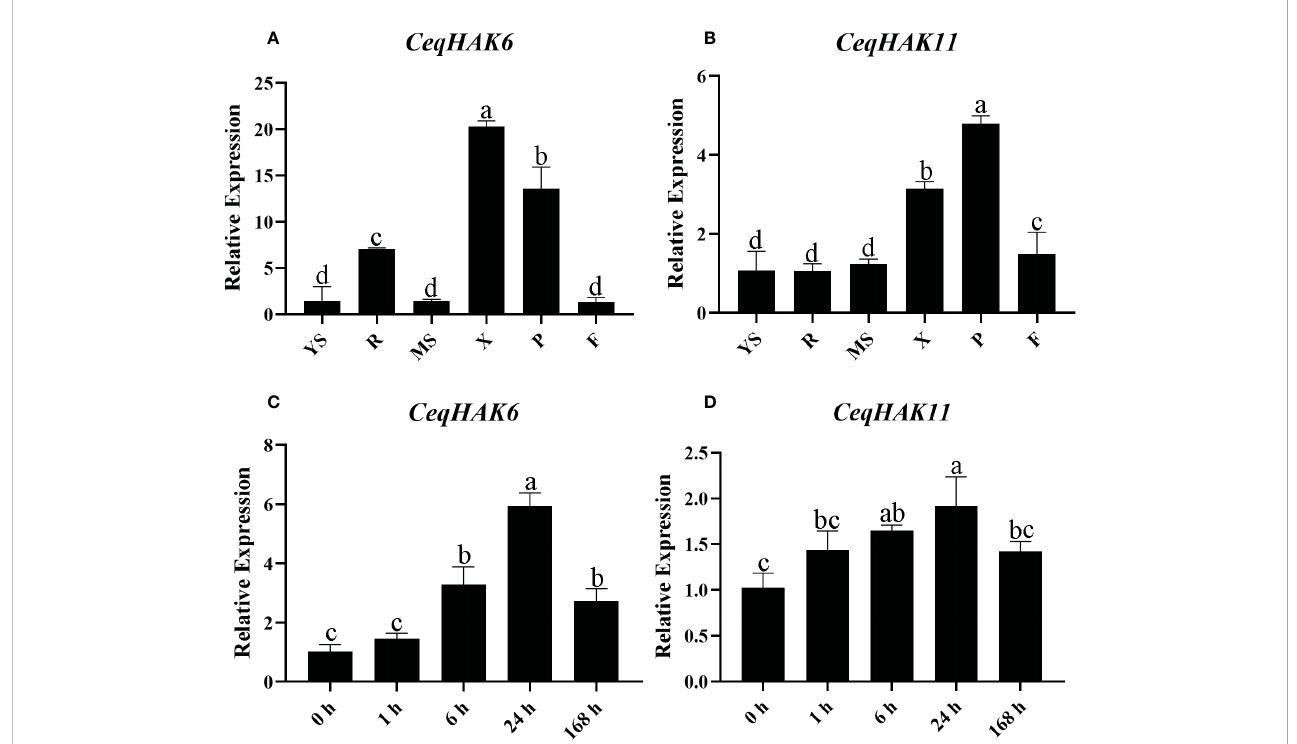
FIGURE 3 Expression analysis of CeqHAK6 and CeqHAK11 genes by qRT-PCR. (A, B) Relative expression of the CeqHAK6 and CeqHAK11 genes in different tissues of C equisetifolia . Data of other C equisetifolia tissues were normalized with the young shoot. YS, Young shoot; R, Root; MS, Mature shoot; X, Xylem of stem; P, Phloem of stem; F, Inforescence. (C, D) Relative expression of the CeqHAK6 and CeqHAK11 genes at different time under NaCl treatment of C equisetifolia . The expression level of CeqEF1 a was used for data normalization. The bars represented the mean ± standard deviation (n = 3). The